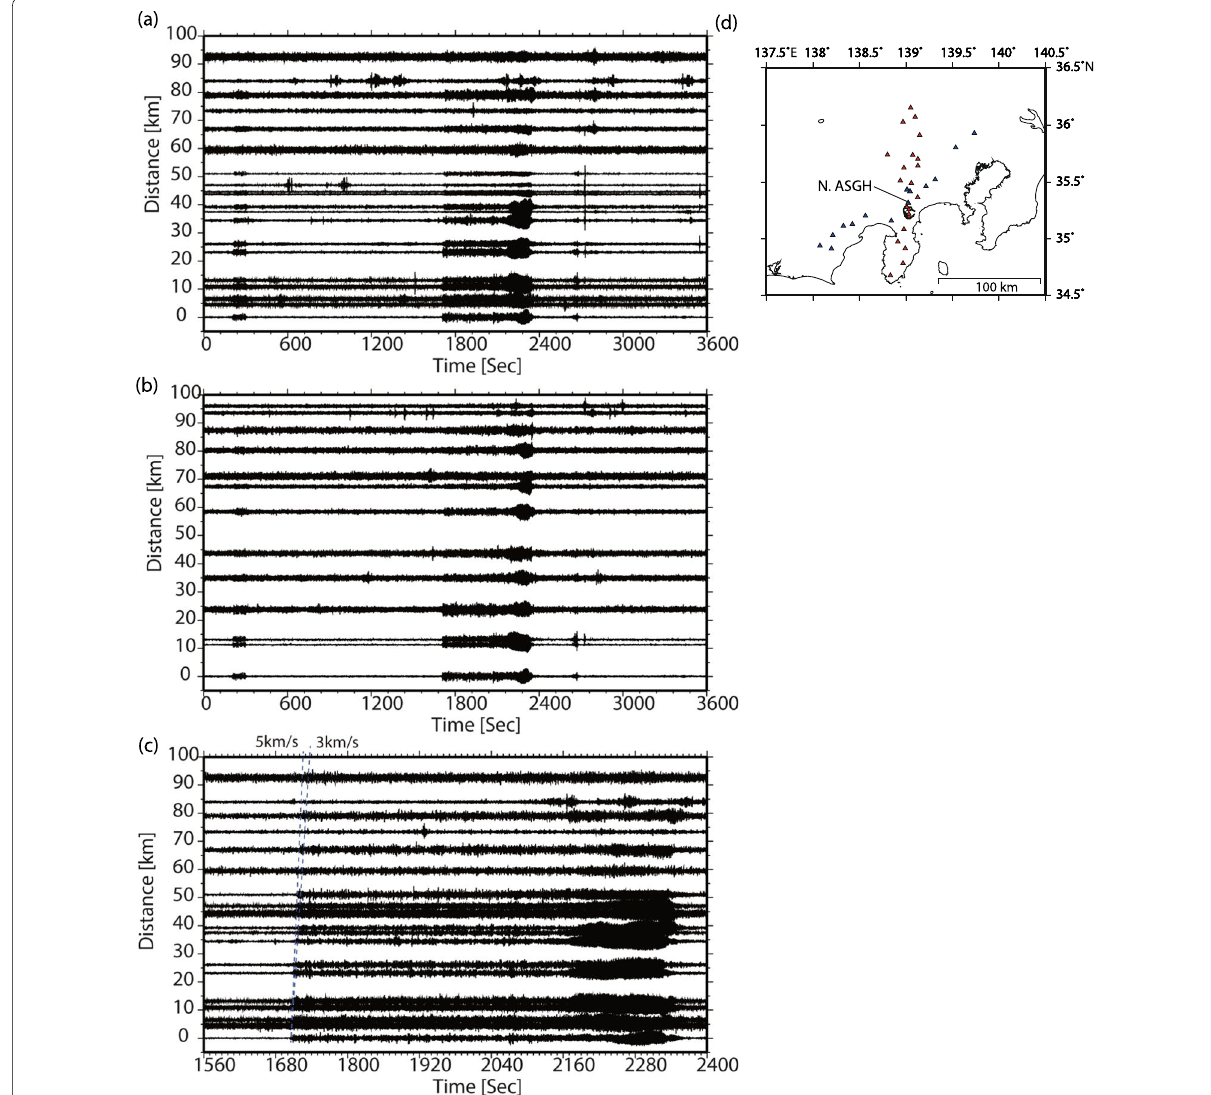
Fig. 2 Record section of velocity waveforms recorded at HSRI and Hi-net stations within 100 km from N.ASGH station during 03:00–04:00 on May 26, 2019 (JST UT 9 h). a and b show the record sections along to N–S (red triangles in d ) and WSW–ENE (blue triangles in d ) sections, = + respectively. c A magnified plot of a during the main tremor signal between 1560 and 2400 s. The two blue broken lines correspond to the traces with the apparent velocity of 3 and 5 km/s. The amplitude of each station was normalized. d Station